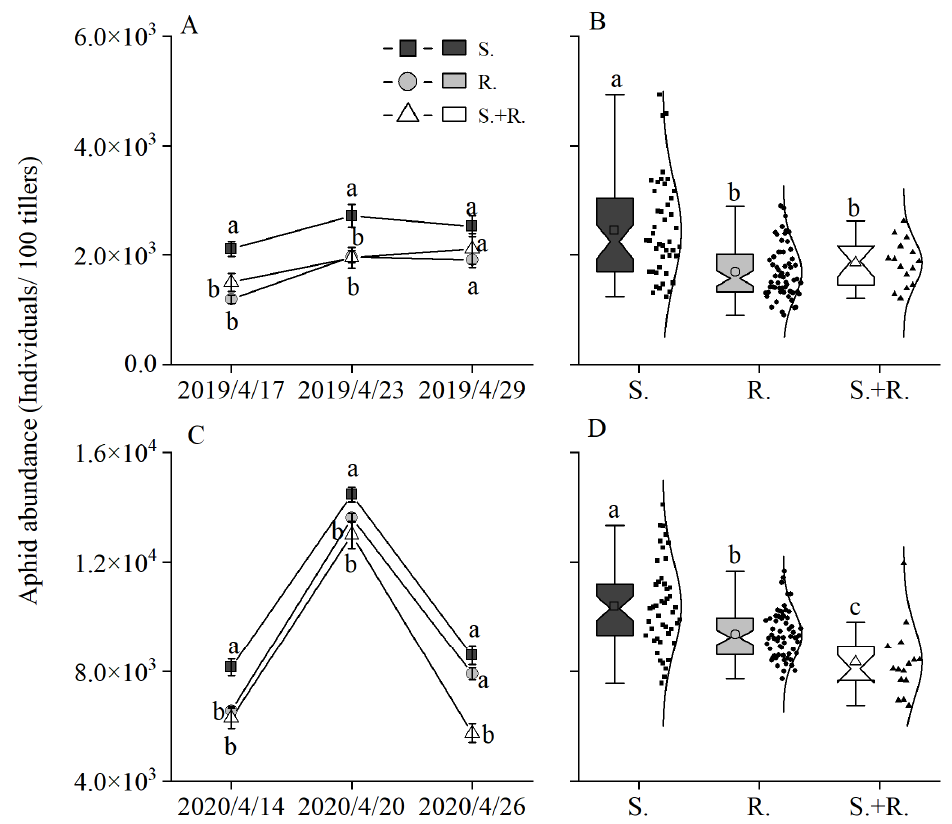
Figure 1. Effect of genotypic diversity of wheat (S: susceptible varieties; R: resistant varieties; S+R: susceptible and resistant varieties) on aphid abundance ( A , C ) and average aphid abundance ( B , D ) in April 2019 and April 2020. Significantly different means within each treatment are indicated by different letters according to the SNK (Student–Newman–Keuls) test: ( A ) 2019/4/17 ( F 2, 117 = 20.182, p < 0.001); 2019/4/23 ( F 2, 117 = 6.758, p = 0.002); 2019/4/29 ( F 2, 117 = 3.518, p = 0.033); ( B ) ( F 2, 117 = 17.046, p < 0.001); ( C ) 2020/4/14 ( F 2, 117 = 14.201, p < 0.001); 2020/4/20 ( F 2, 117 = 6.134, p = 0.003); 2020/4/26 ( F 2, 117 = 12.111, p < 0.001); ( D ) ( F 2, 117 = 18.214, p < 0.001).